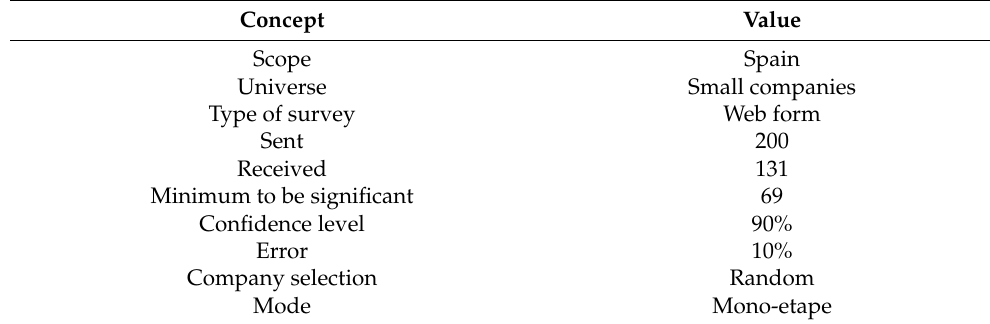
Table 1. Description of the